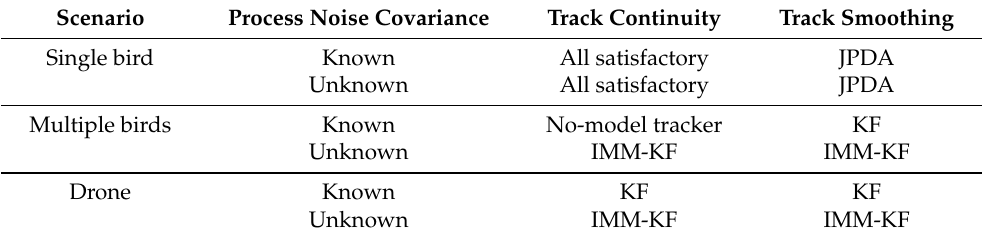
Table 2. Summary of the conclusions drawn from the